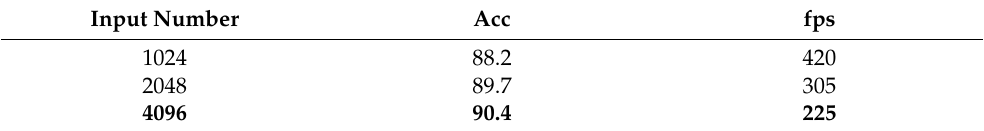
Figure 7. The first row shows the corresponding RGB images, and the second row shows the depth images. The third to fifth rows are point clouds transformed from the depth images, and they contain 4096, 2048, and 1024 points, respectively. Table 4. Performance evaluation with different input numbers of points.